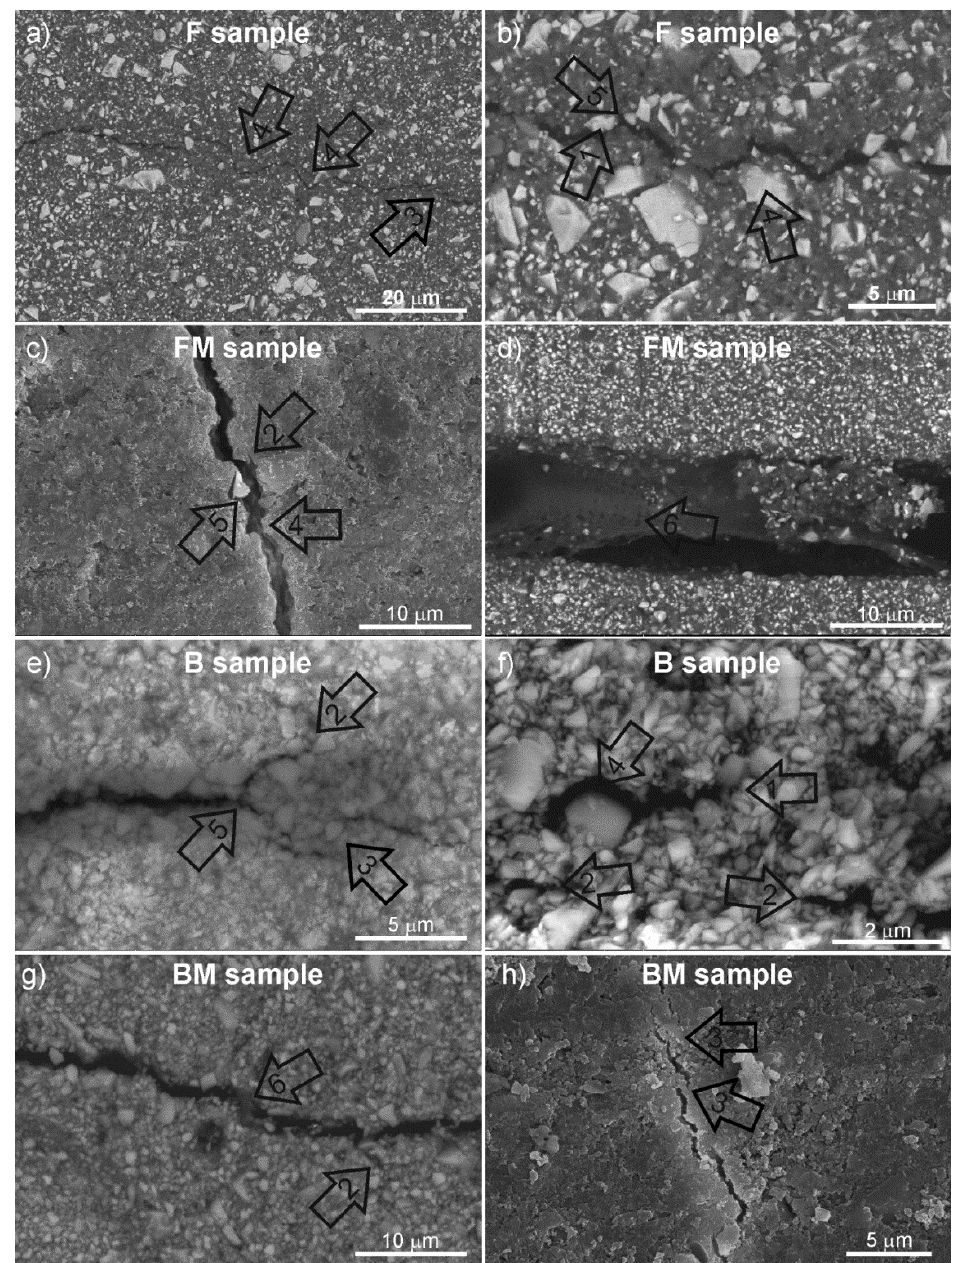
Figure 4. Scanning electron microscopy (SEM) images presenting fractures and toughening features in the tested composites (different magnifications for each pair of images): ( a ) and ( b ) F sample; ( c ) in the tested composites (di ff erent magnifications for each pair of images): ( a , b ) F sample; ( c , d ) FM and ( d ) FM sample; ( e ) and ( f ) B sample; ( g ) and ( h ) BM sample; 1—blocking, 2—secondary cracks, sample; ( e , f ) B sample; ( g , h ) BM sample; 1—blocking, 2—secondary cracks, 3—bridging, 4—deflection 3—bridging, 4—deflection and bypassing particles, 5—bifurcation, and 6—elastic bridge. and bypassing particles, 5—bifurcation, and 6—elastic